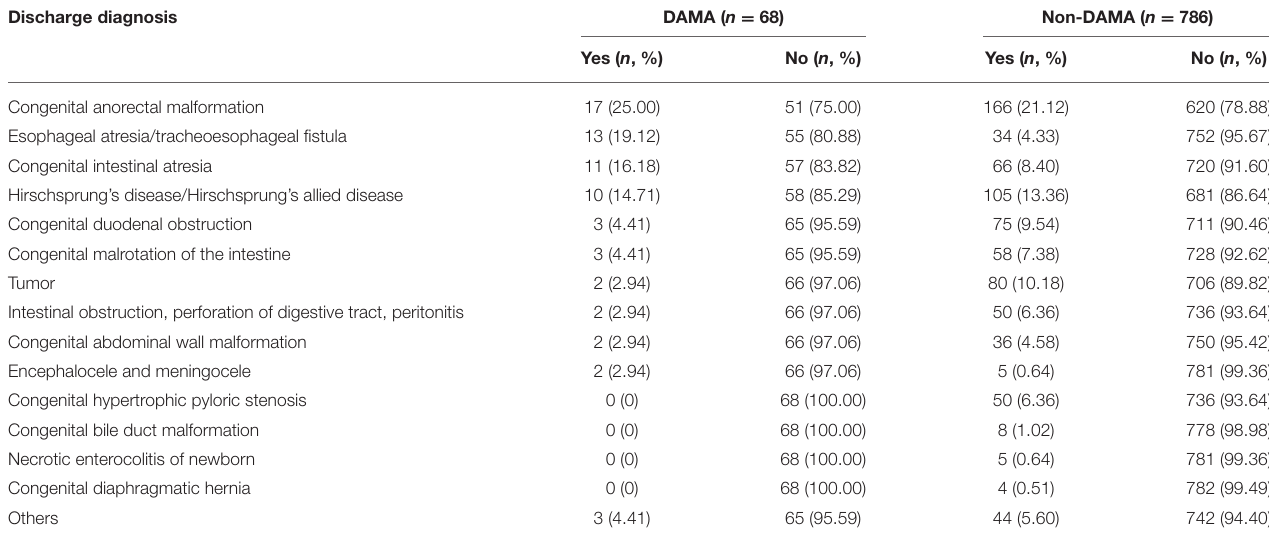
TABLE 2 | The disease distribution of the DAMA and non-DAMA